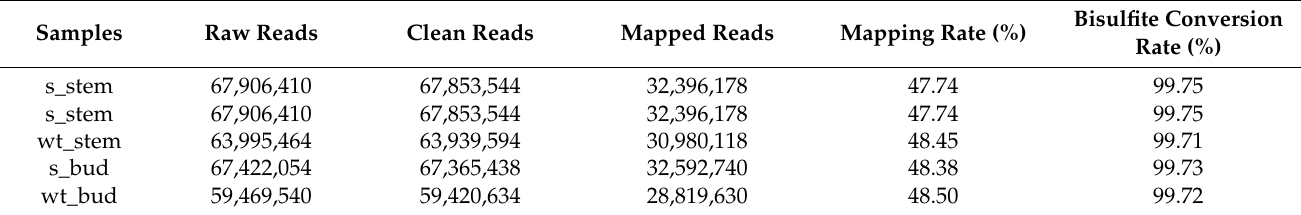
Table 1. Summary of whole-genome bisulfite sequencing